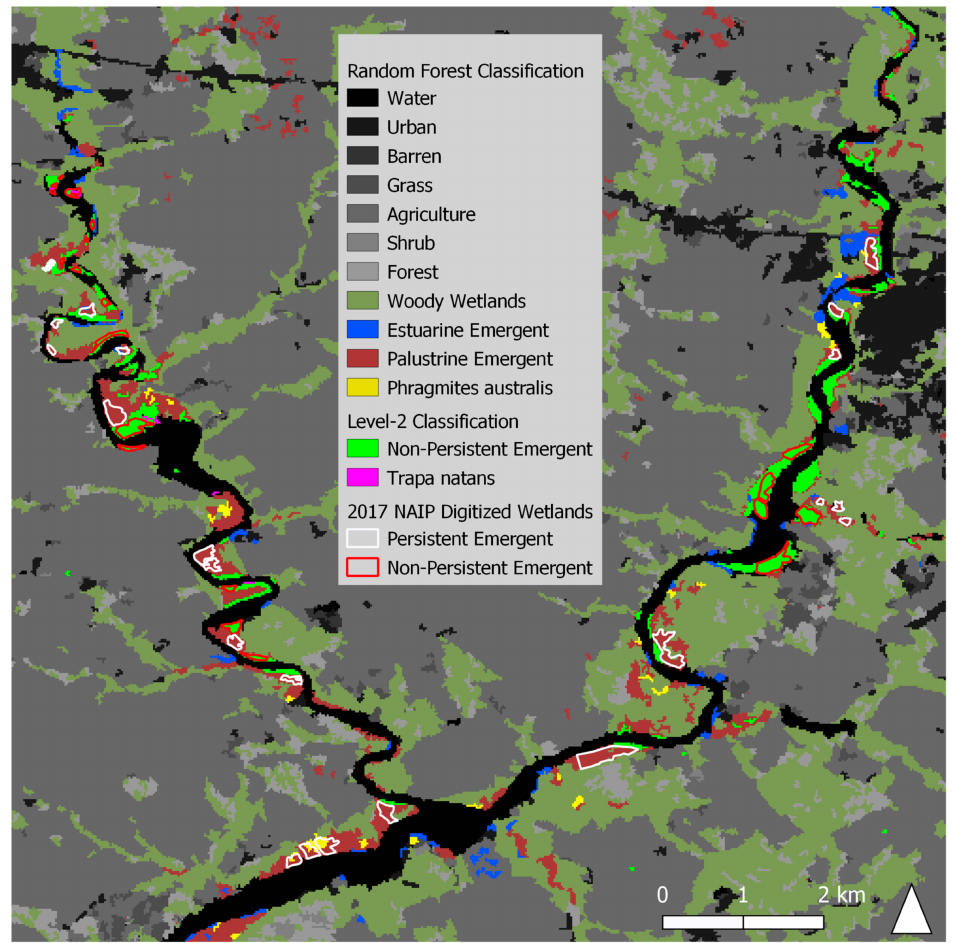
Figure 16. Comparison between Choptank River level-2 and level-1 classified wetland extents and independent validation with 2017 NAIP digitized wetland dataset. Identified non-persistent wetlands in the NAIP dataset were primarily Nuphar spp. Non-persistent emergent classification occurrence accuracy was 93.60%. Persistent emergent classification occurrence accuracy was 95.79%.